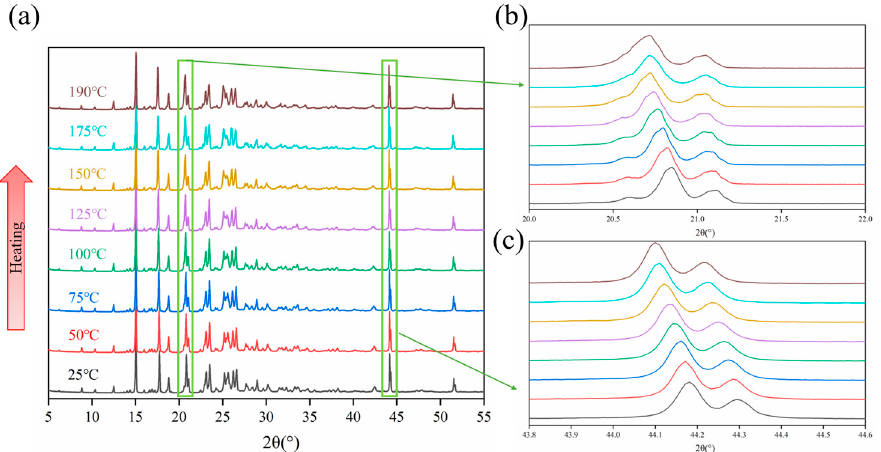
Figure 3. ( a ) VT-PXRD (Variable-temperature powder X-ray diffraction) patterns of TMP-25HBA during heating from 25 °C to 190 °C. ( b ) The PXRD peak shift of near 21.0°. ( c ) The PXRD peak shift of near 44.2°.